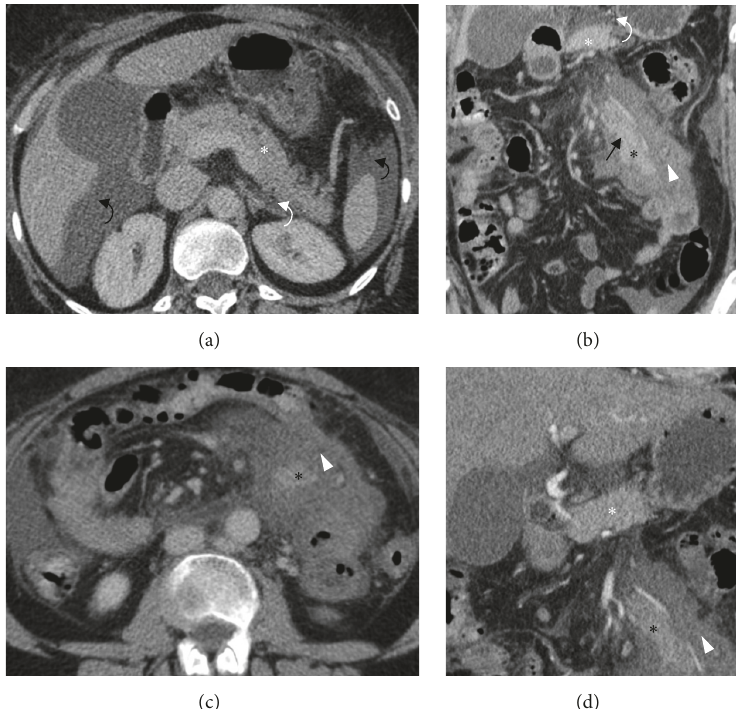
Figure 1: CT scan performed at the third day of admission. (a) Axial CT image in the portal venous phase. Normal appearance of the orthotopic pancreas (white asterisks) . A nonsignificant small amount of retroperitoneal fluid on the level of the pancreas tail (white curved arrows) . Presence of a large amount of free intraperitoneal fluid (black curved arrows) . (b-c) Coronal and axial CT image in the portal venous phase. Enhancing soft tissue mass (black asterisk) with surrounding mesenteric edema (white arrowhead) . Suggestion of a central ductal structure (black arrow) . (d) Coronal CT image in the early arterial phase shows a comparable enhancement of the orthotopic and heterotopic pancreas (resp., white and black asterisks)